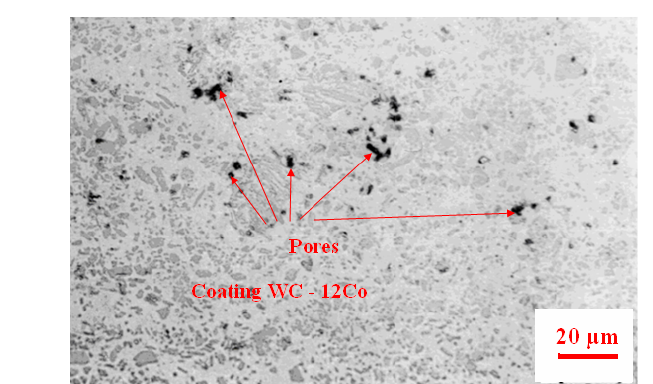
Figure 6 – Microstructure of the WC – 12wt.%Co coatingdeposited with a helium feed rate of 16 l/min